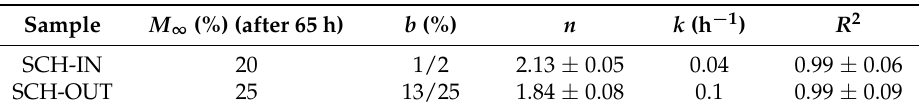
Table 5. Kinetic parameters of SDZ release from coaxially electrospun SCH-OUT and SCH-IN samples at pH 6. Modified Korsmeyer-Peppas model, second release